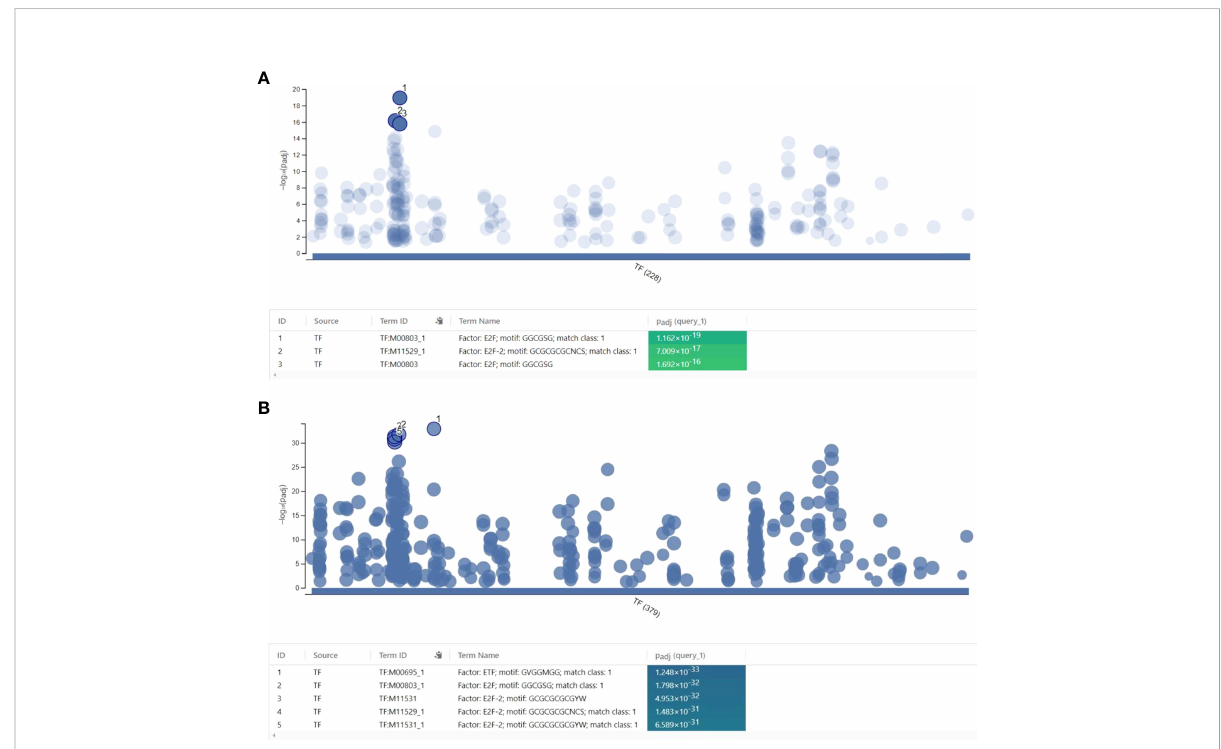
FIGURE 5 Regulatory motif analysis of the co-localization of NF- k B and NS1. (A) Motif analysis of the co-localization of NF- k B and NS1 at promoter regions less than 3000 base pairs. (B) Motif analysis of the co-localization of NF- k B and the NS1